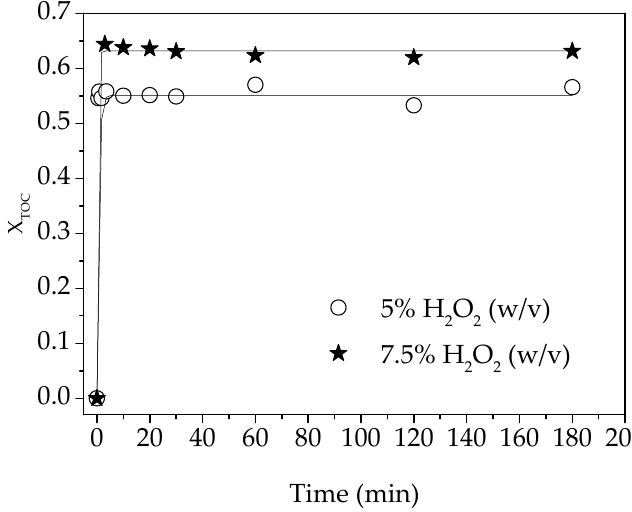
Figure 6. Variation of TOC conversion values of OMW throughout the photodegradation reaction time. Operating conditions: Initial concentration of the H 2 O 2 solution used = 5.0% and 7.5% (w/v); pH = 3.0; T = 20 °C; agitation rate = 600 rpm and [FeCl 3 ]/[H 2 O 2 ] ratio = 0.03. Solid line corresponding to the model adjustment.